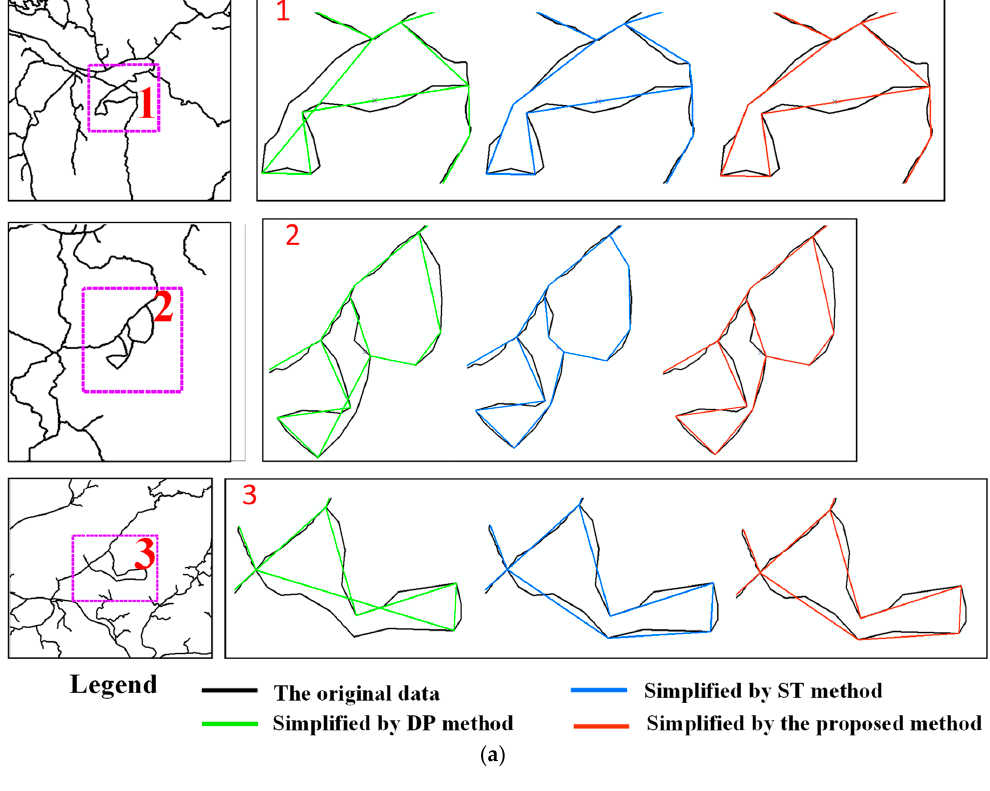
Figure 3. ( a ) The curve T which processed by D – P algorithm; ( b ) three monotonic chains 1 T